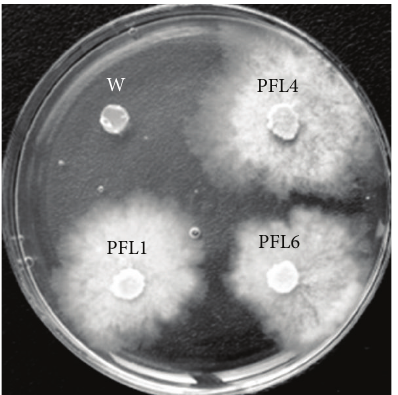
Figure 3: Genetic stability analysis of transformants on PDA medium containing 50 ug/mL hygromycin B after subculturing for five generations on PDA plates without antibiotics. Three independent transformants (PFL1, PFL4, and PFL6) exhibit normal growth on hygromycin B containing medium and wild-type strain LXS240101 (W) shows no growth. The plates were incubated at 25 ∘ C for 48